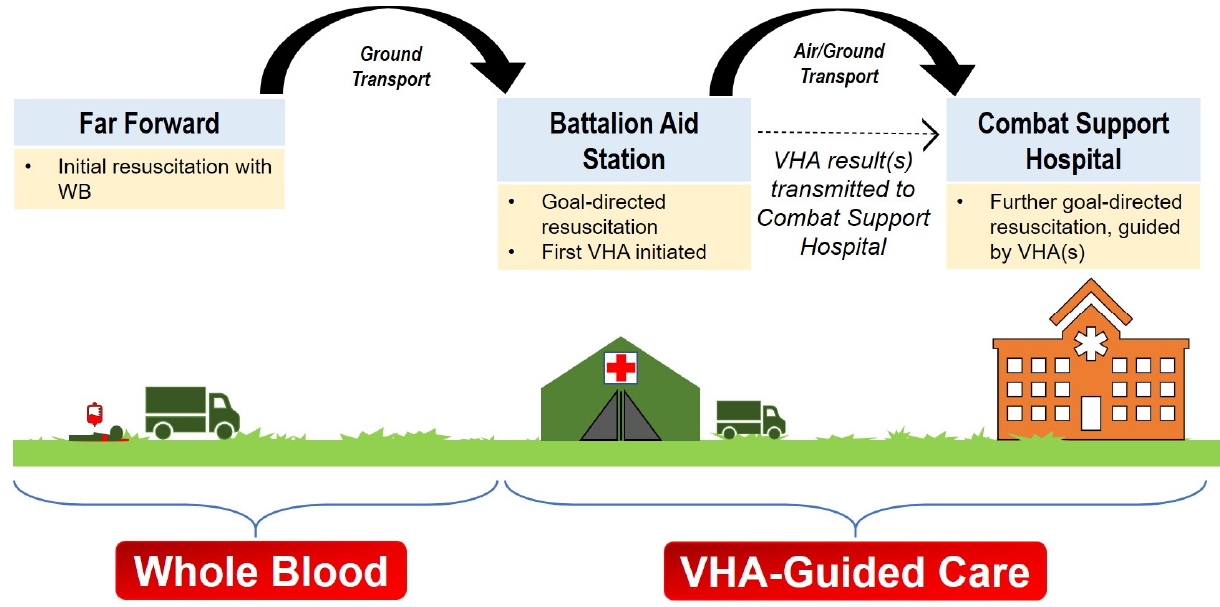
Figure 2. Proposed Use of VHA for Hemorrhagic Resuscitation in the Far-Forward Combat Envi- ronment. The hemorrhaging soldier is initially transfused WB (or fixed ratio) according to military protocol and blood product availability. While being resuscitated and prior to evacuation, the medics may obtain a blood sample and start the viscoelastic hemostatic assay (VHA). While the patient is en route to the Battalion Aid Station, the VHA result from the far-forward is transmitted to the Battalion Aid Station. Here, the far-forward VHA result—as well as a new VHA at the Battalion Aid Station—may guide goal-directed blood-component therapy. If the patient is to be transported further, the prior VHA results may be transmitted to the Combat Support Hospital. At the Combat Support Hospital, all future transfusions are guided by adjunctive VHA results to treat the patient’s individual hemostatic phenotype.